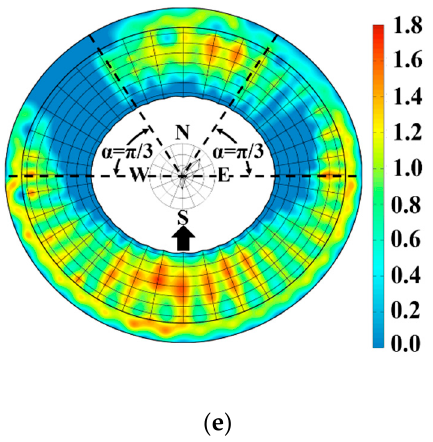
Figure 9. Snow distribution shape coefficient μ : ( a ) 0°; ( b ) 22.5°; ( c ) 45°; ( d ) 67.5°; and ( e ) 90°.